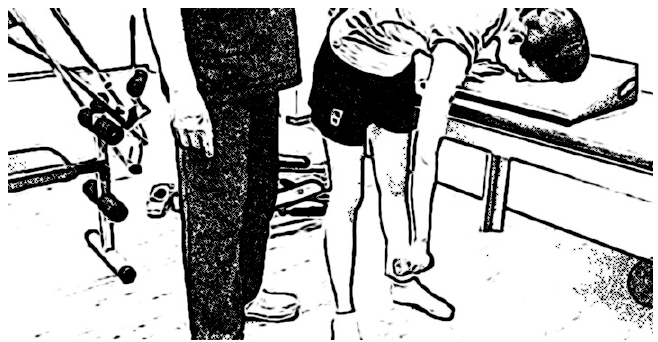
Figure 5. An example of an exercise performed by the physiotherapist during section two. Codman’s (pendulum) exercises.